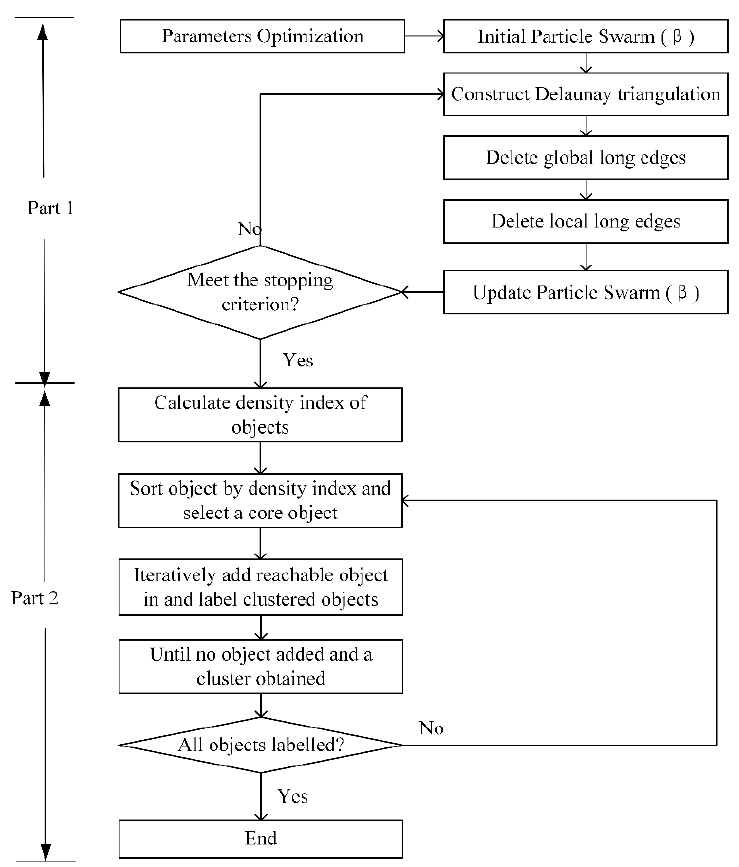
Figure 3. The procedure of the adaptive density-based time series clustering (DTSC) algorithm.